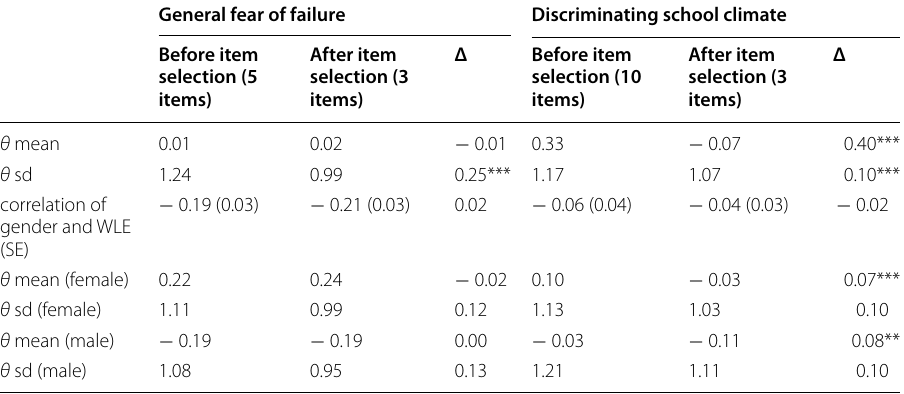
Table 3 Descriptive results for the two scales General Fear of Failure and Discriminating School Climate before and after item